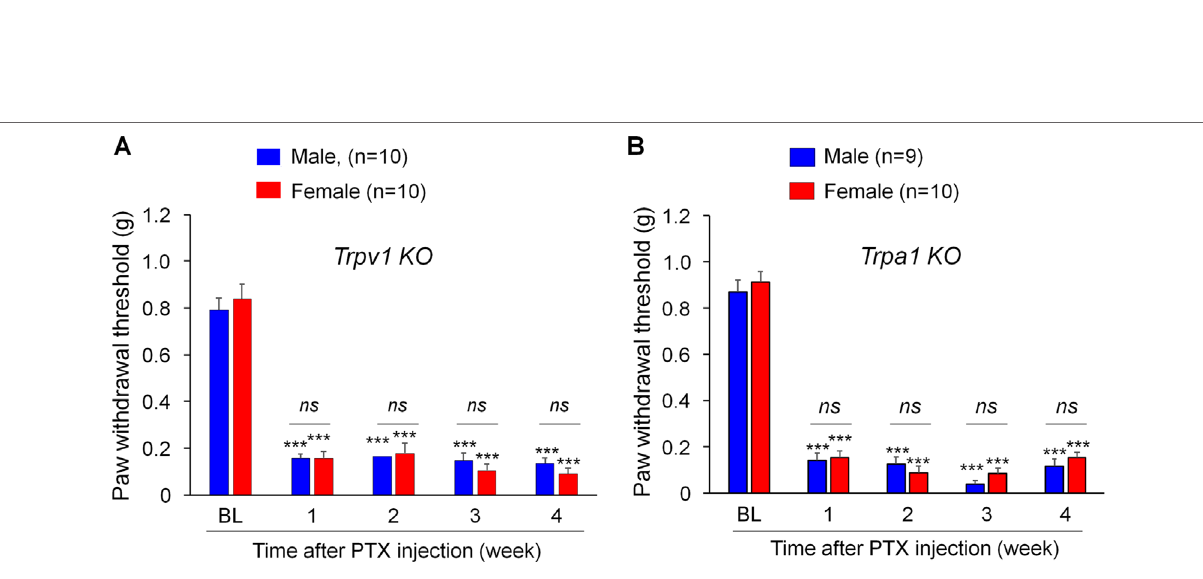
FIGURE 2 | PTX induces sustained mechanical allodynia in Trpv1 (A) and Trpa1 (B) knockout (KO) mice of both sexes. Mechanical allodynia after PTX injection is fully developed in mice lacking trpv1 (A) and trpa1 (B) from week 1 and week 4, showing no sex differences. ***p < 0.001 vs. the baseline (BL) control. ns., not significant. Two-way ANOVA with Bonferroni’s post hoc test, n = 9-10 mice per sex per